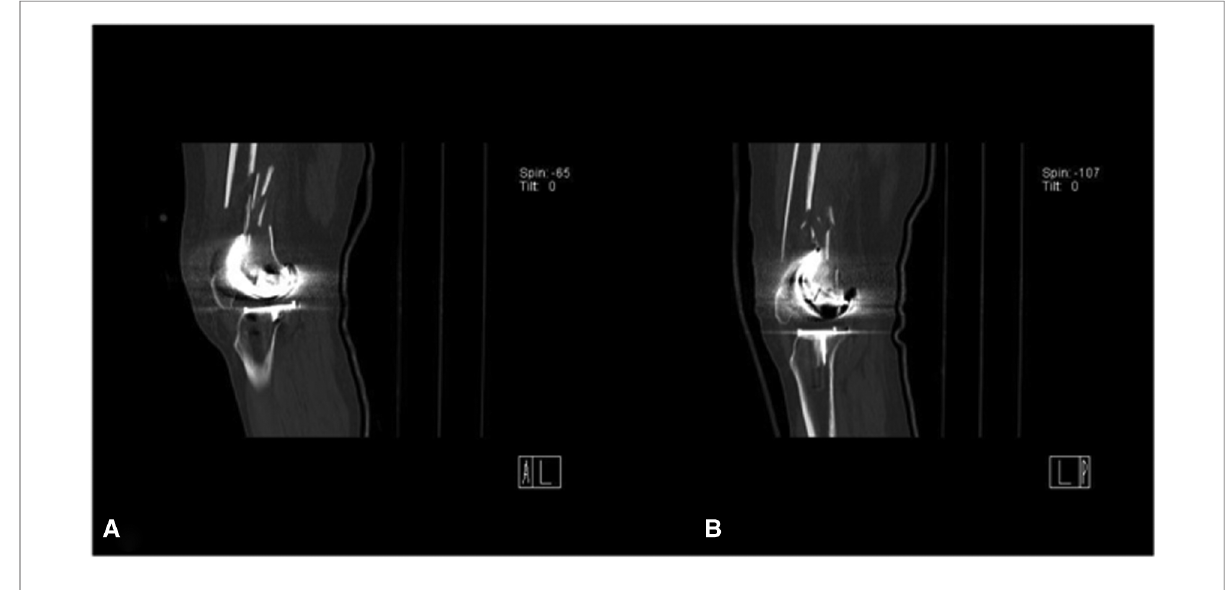
FIGURE 1 Preoperative sagittal CT of bilateral knees: the right knee ( A ), the left knee ( B